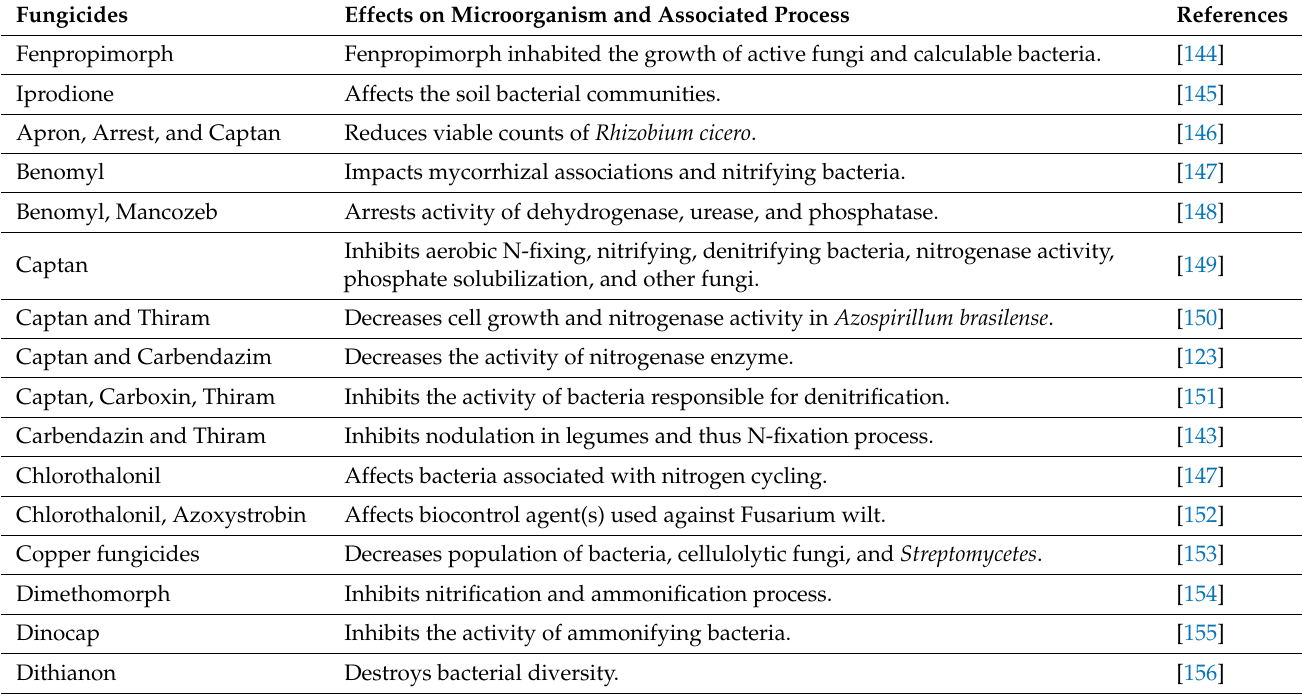
Table 2. Different fungicides with their reported effects on soil microorganisms and biochemical